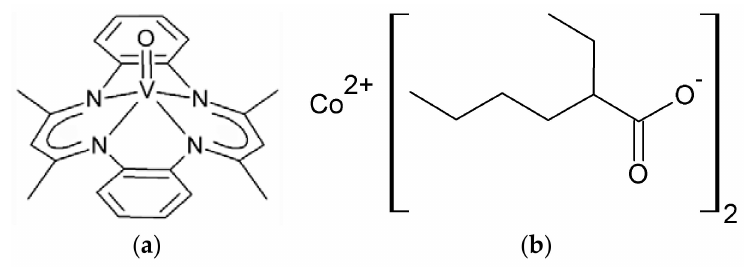
Figure 2. Primary driers under the study: ( a ) VO; ( b )